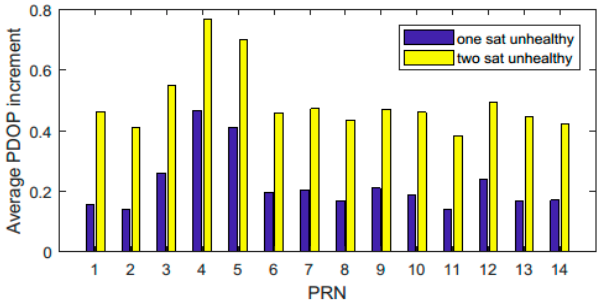
Figure 10. Average position dilution of precision (PDOP) increments in the BDS service area when one or two satellites were unhealthy in January 2018.